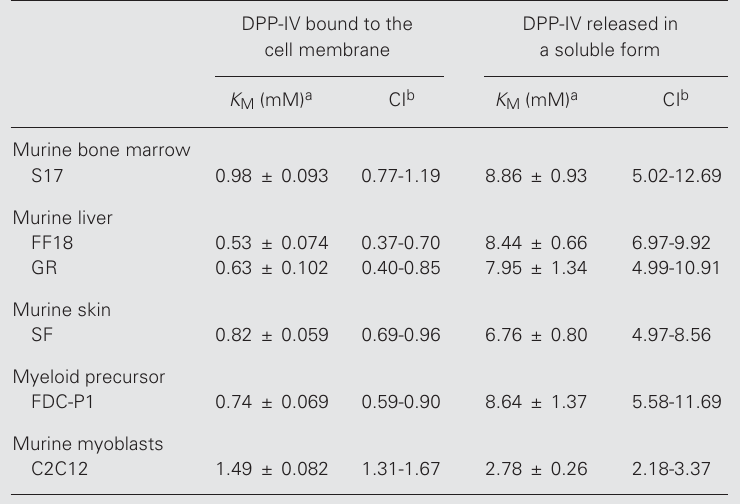
Table 1. Apparent K M for dipeptidyl peptidase IV (DPP-IV) activity in the cell layer and released in the soluble form into the supernatants of cell